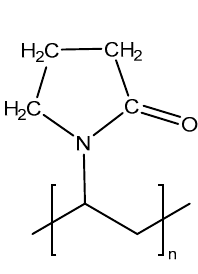
Figure 3. The polyvinylpyrrolidone polymeric unit.